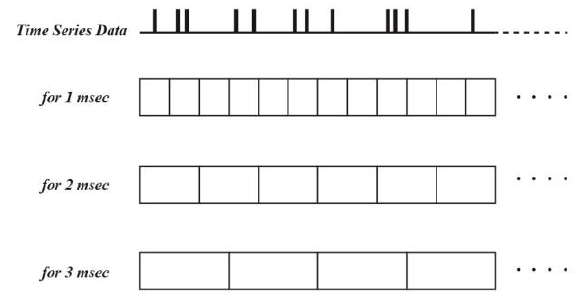
Figure 1. Schematic view of the Bunching method